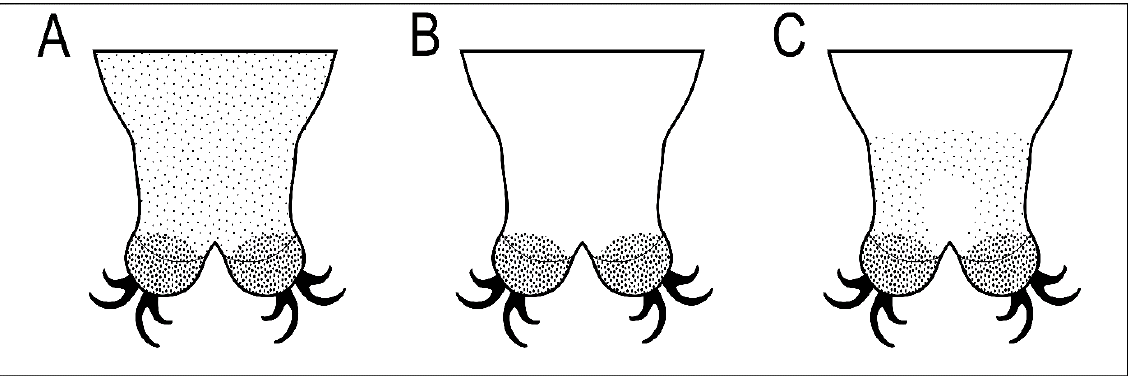
Figure 10. Schematic representation of three types of body granulation in the caudal region of the last body segment seen under light microscope (LM) in four Macrobiotus species: ( A ) Macrobiotus joannae Pilato & Binda, 1983 and Macrobiotus punctillus Pilato, Binda & Azzaro, 1990 (evenly distributed granulation clearly visible under LM); ( B ) Macrobiotus hannae Nowak & Stec, 2018 (body granulation granulation not visible under LM); ( C ) Macrobiotus rebecchii sp. nov. (granulation visible as a specific band on the dorso- and latero-caudal surface of the last body segment, while smaller granulation on the remaining body surface is not visible under LM).